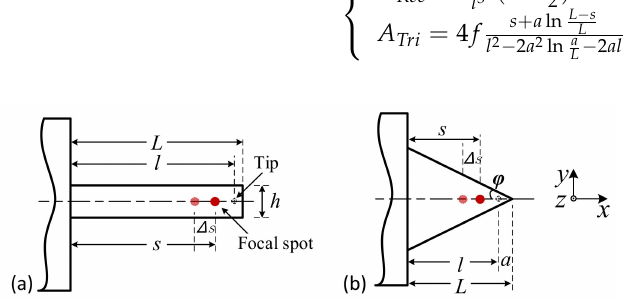
Figure 5. Diagram of focused spot movement on the cantilever. ( a ) Rectangular cantilever; ( b ) triangular cantilever.